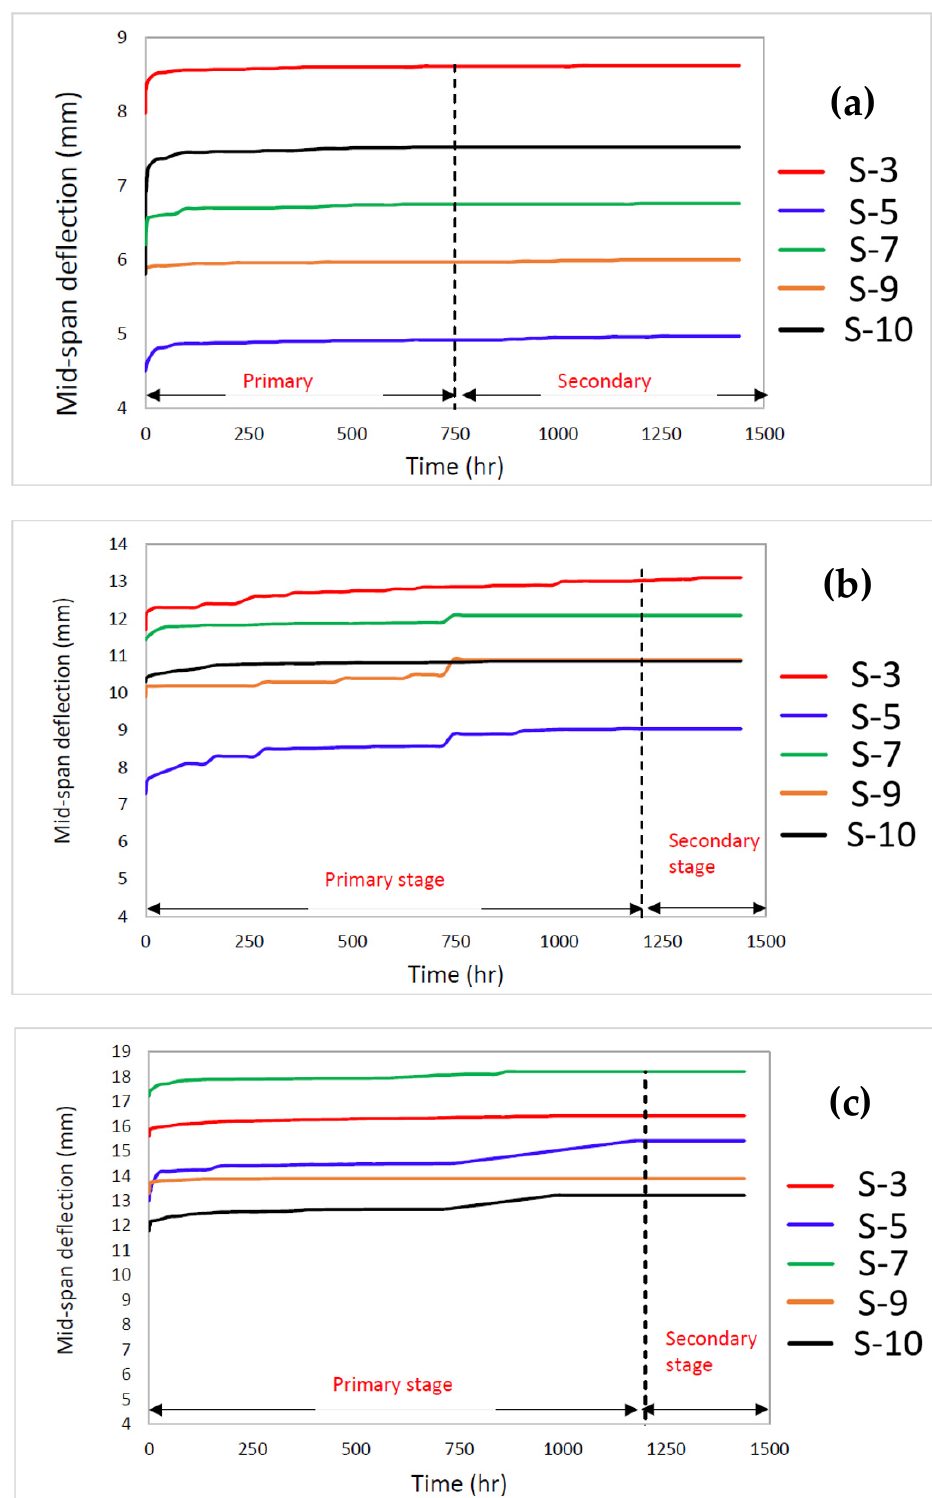
Figure 6. Creep deflection for pGFRP cross arm that subjected to ( a ) 12%; ( b ) 24%; and ( c ) 37% of load levels.